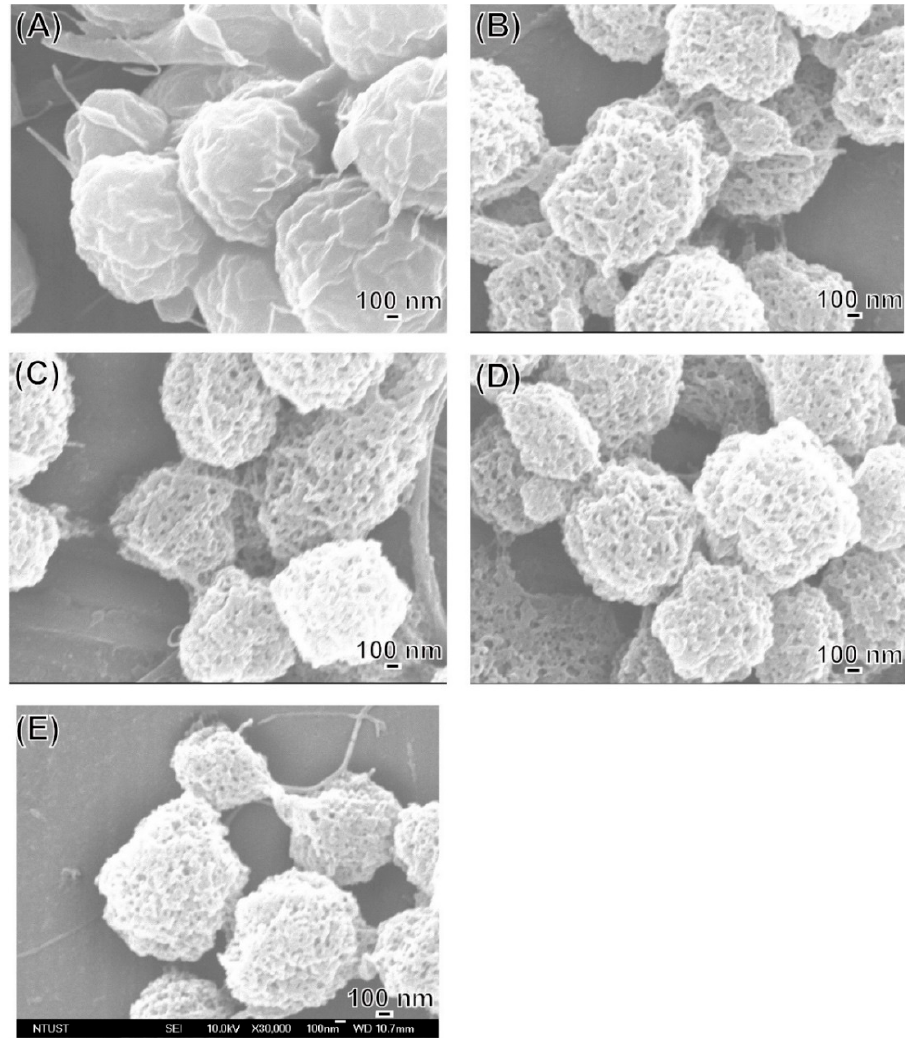
Figure 5. SEM images of LEVA / PVP / PMMA microparticles infiltrated in distilled water at the time points of ( a ) 0, ( b ) 20, ( c ) 40, ( d ) 90 min and ( e ) 24 h.